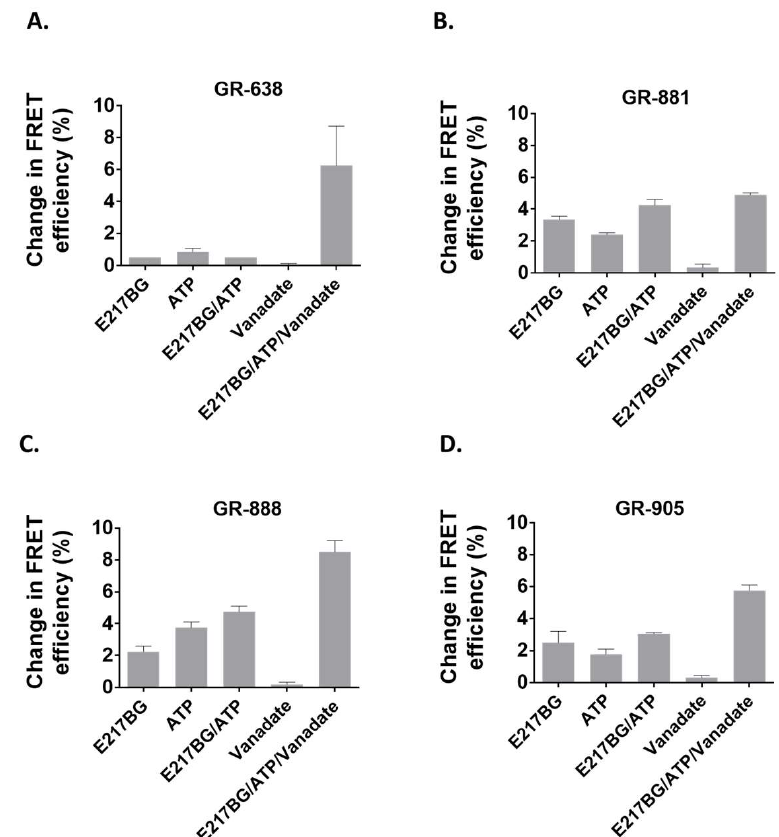
Figure 6. Ligand-dependent intramolecular FRET measurements. ( A ) Ligand-dependent FRET changes of GR-638 protein. ( B ) Ligand-dependent FRET changes of GR-881 protein. ( C ) Ligand-dependent FRET changes of GR-888 protein. ( D ) Ligand-dependent FRET changes of GR-905 protein. Firstly, 20 µ g of protein in Tris–sucrose buffer was prepared and incubated with 5 µ M estradiol glucuronide (E217 β G) and/or 4 mM/5 mM ATP/MgCl 2 and 1 mM sodium vanadate for 10 min prior to